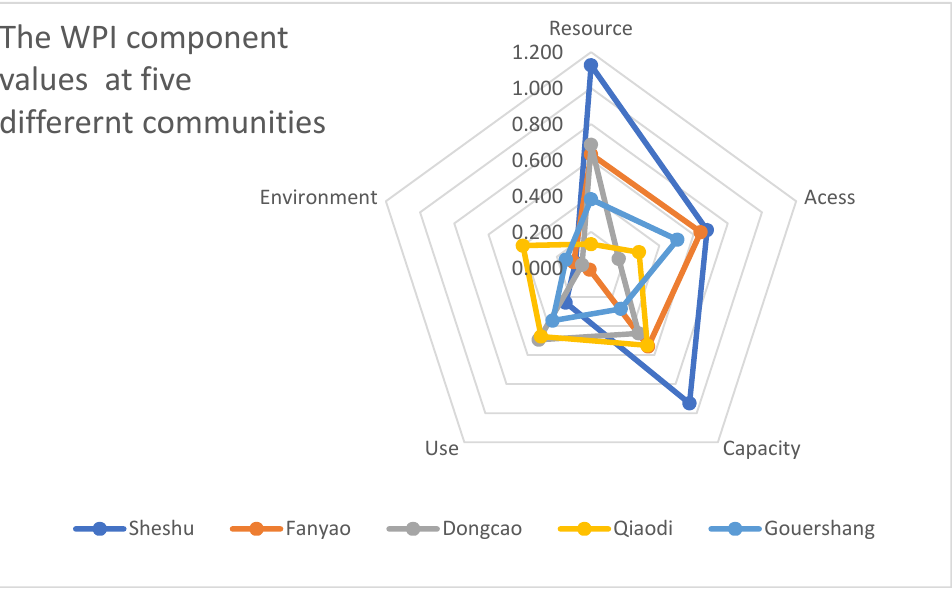
Figure 2. WPI component scores.